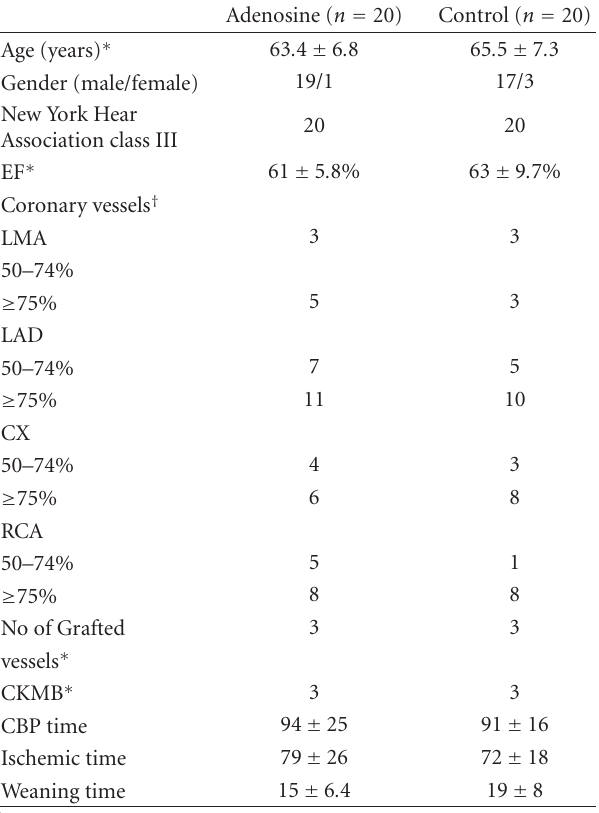
Table 1: Base line Patient Characteristics and operative data.